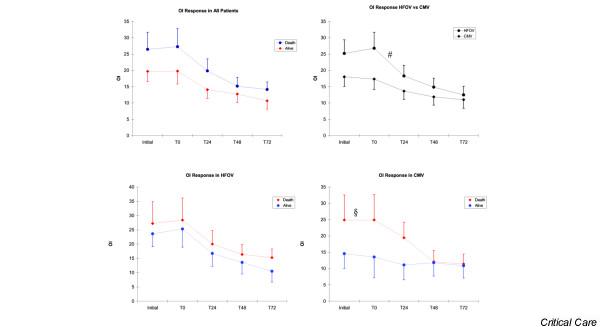
Oxygenation index (OI) in survivors versus non-survivors and high frequency oscillatory ventilation (HFOV) versus conventional mechanical ventilation (CV). OIs are represented by diamonds as means with bars as 95% confidence intervals (CI). Reported p-values for baseline OI are corrected for study site, ventilatory index, APACHE II score, age and weight. The baseline OI did not significantly predict mortality in all patients or in HFOV (p = 0.06 and p = 0.41, respectively). §Baseline OI was significantly different between survivors and non-survivors in the CV group (p = 0.04). Significant differences between OI responses were calculated by linear mixed model analyses. #Significant difference in OI response between HFOV and CV (p = < 0.01). OI response did not differentiate between survivors and non-survivors in all patients or in CV and HFOV separately (p = 0.28, p = 0.12 and p = 0.95, respectively).